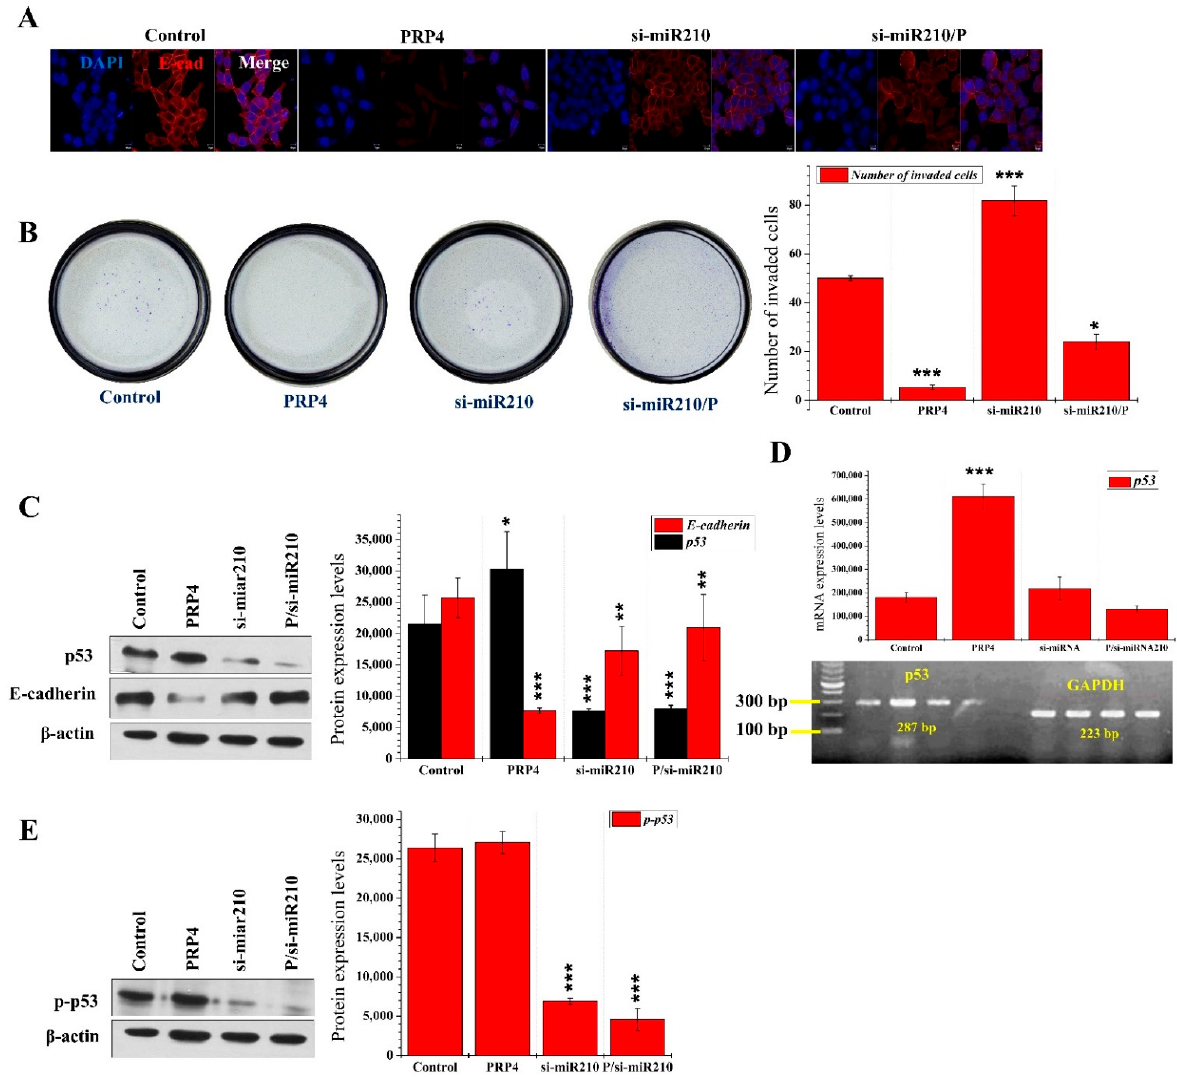
Figure 5. PRP4 induces epithelial–mesenchymal transition (EMT) and blocks cell invasion by up- regulating miR-210 and p53: ( A ) Immunofluorescence microscopy images documenting E-cadherin expression in response to PRP4 overexpression and/or miR-210 silencing in HCT116 cells. Cells were immunostained with an anti-E-cadherin antibody, and nuclei are visualized by DAPI staining; ( B ) cellular invasion assay. Blue spots represent invading HCT116 cells. PRP4 overexpression results in a decreased invasion of HCT116 cells, while miR-210 silencing blocks PRP4 activity. * p < 0.05, *** p < 0.001; ( C , E ) Western blots were performed using antibodies (1:1000 dilution) specific for total and phosphorylated p53; actin was used as an internal control. * p < 0.05, ** p < 0.01, *** p < 0.001; ( D ) expression of p53 mRNA, GAPDH was used as a loading control. *** p < 0.001.